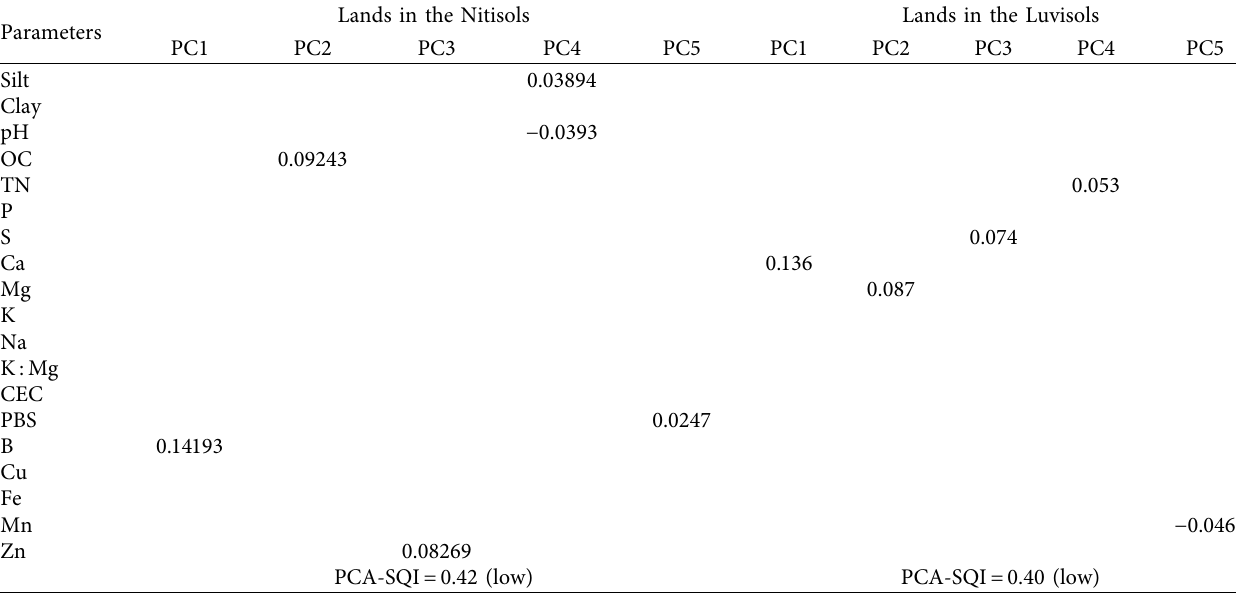
Table 7: Soil quality index (SQI) values of lands in the Nitisols and Luvisols based on PCA.